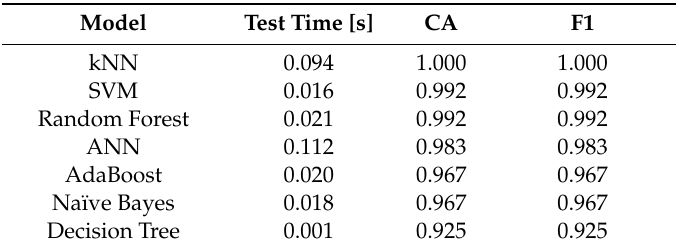
Table 6. Classifiers performance, in the test dataset, using the selected best 3 input features mapped by